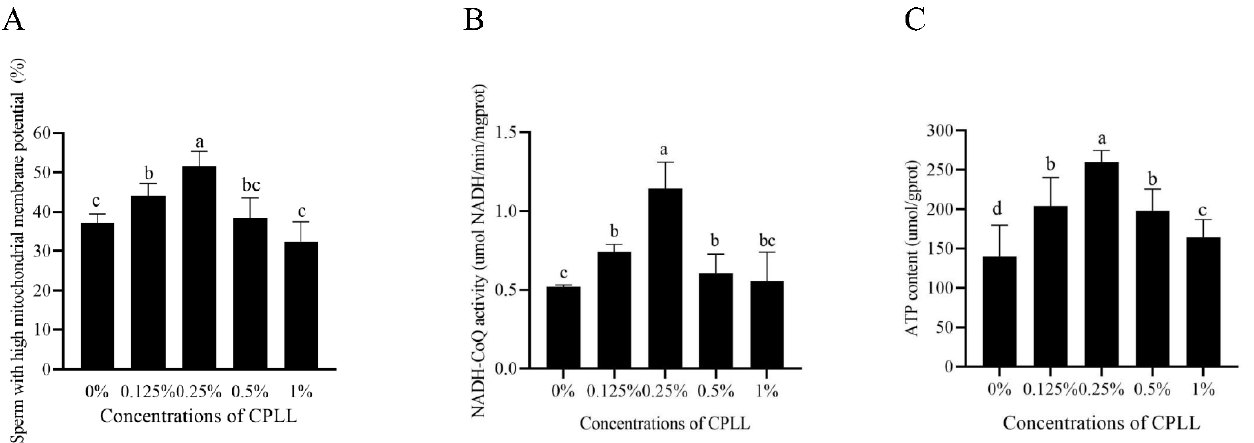
Figure 2. Effects of supplementation with different concentration of CPLL to the freezing medium on post-thaw boar sperm mitochondrial membrane potential ( A ), NADH-CoQ activity ( B ), and ATP level ( C ). Values are specified as mean ± standard error of the mean (SEM). Columns with different lowercase letters differ significantly ( p < 0.05), n = 5.